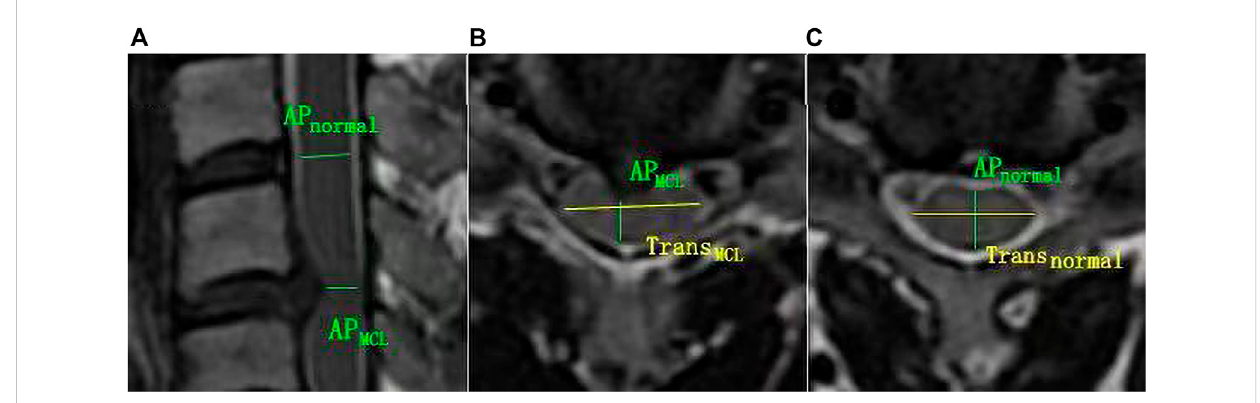
FIGURE 2 The schematic diagram for diameter measurement. (A, B) AP MCL = anteroposterior diameter of the spinal cord at MCL, and Trans MCL = transverse diameter of thespin cord at MCL. (A, C) AP normal = anteroposterior diameter of normal level spin cordnearest theMCL. Trans normal = transverse diameter of normal level spin cord nearest the MCL.